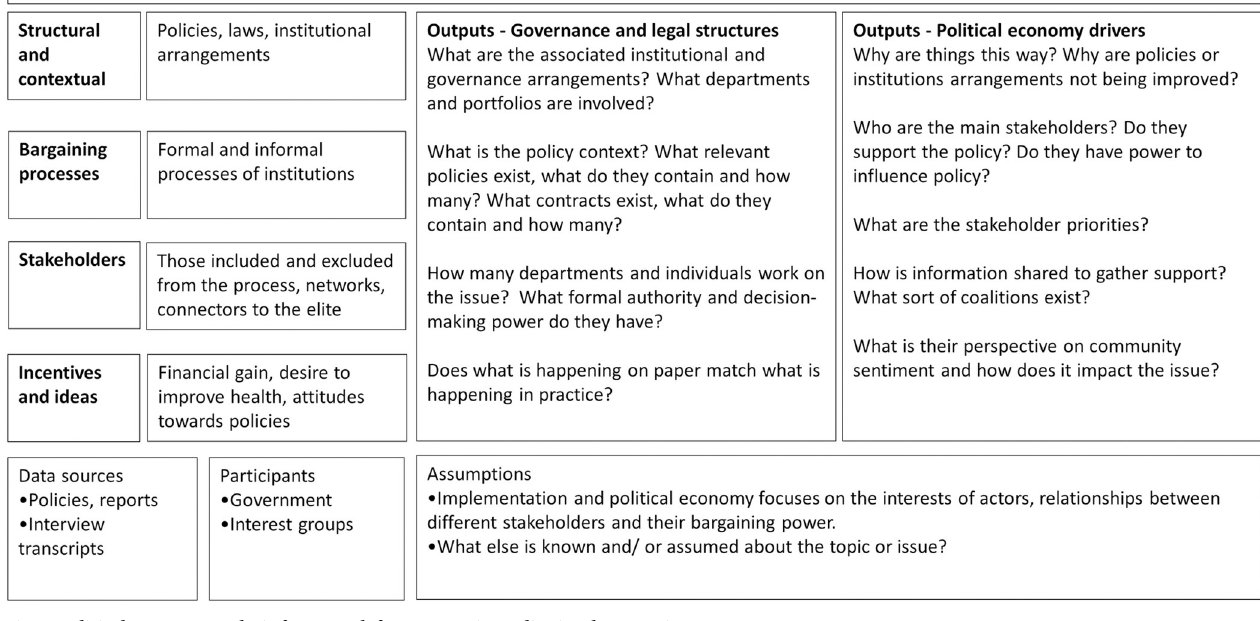
Fig 1. Political economy analysis framework for prospective policy implementation.